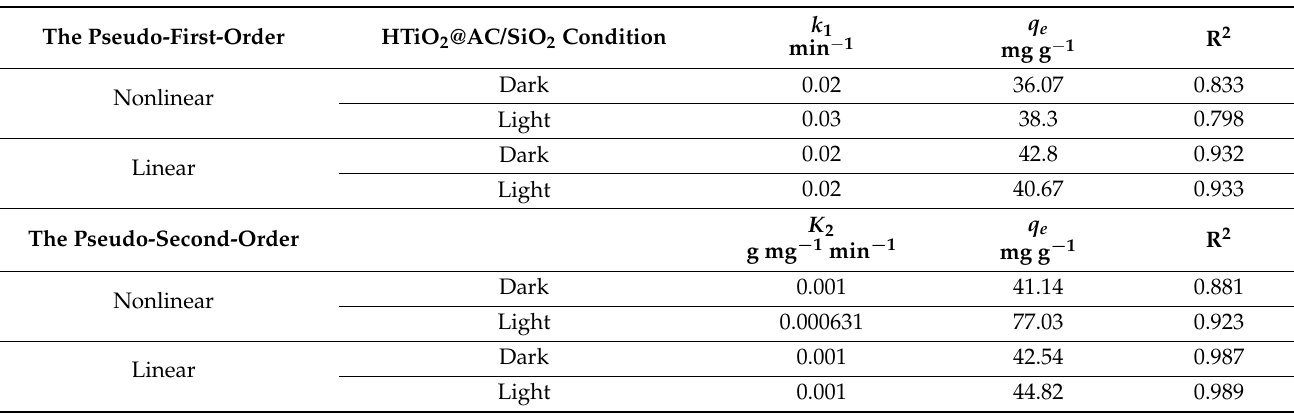
Table 2. Biosorption kinetics.